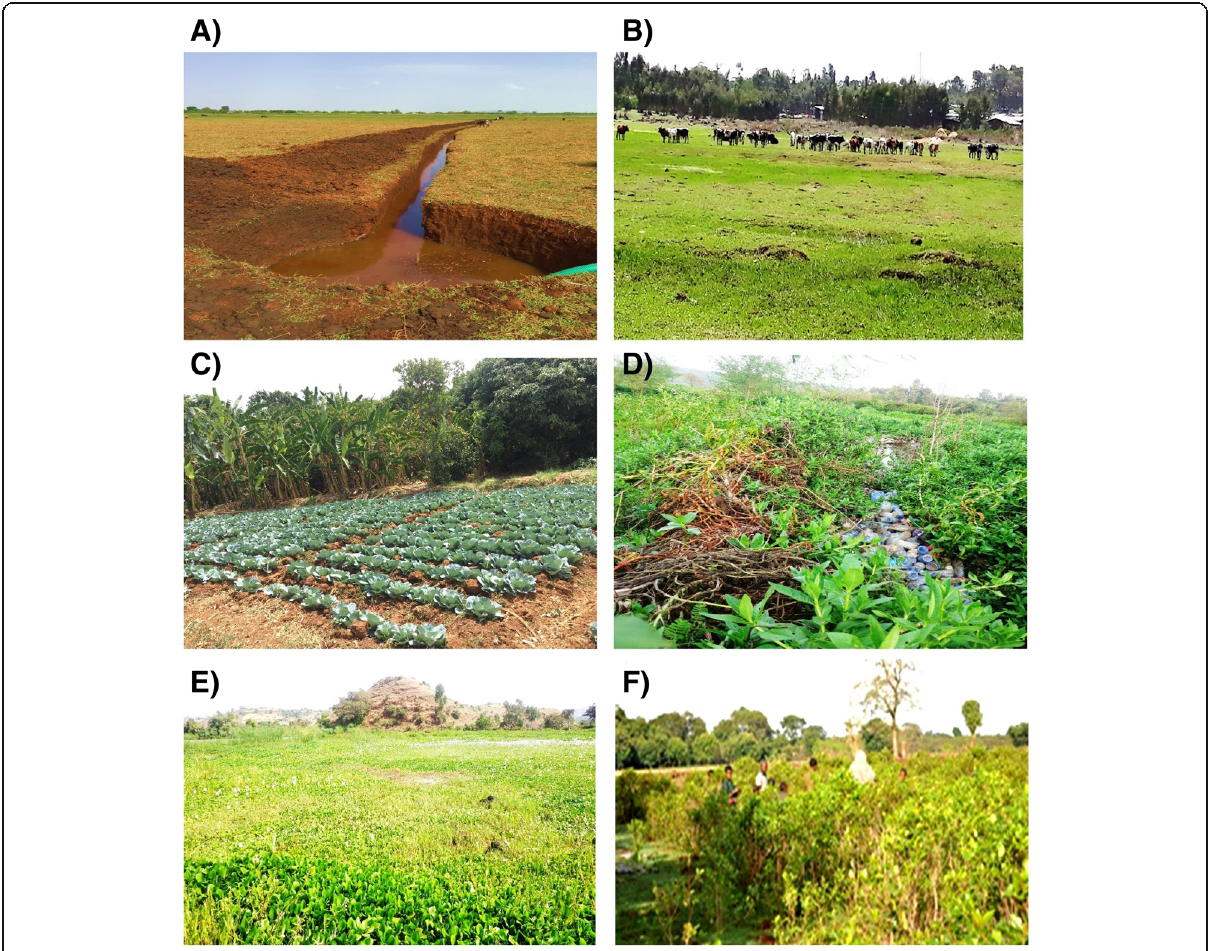
Fig. 5 Photographs showing anthropogenic activities affecting wetland ecosystem in urban and peri-urban areas of Bahir Dar City. a Water withdrawal from the wetland for irrigation. b Eucalyptus plantation and illegal settlement. c vegetables cultivation. d pollutants discharging into the wetland. e an invasion of water hyacinth on the Blue Nile riverbank, including nearby wetlands. f Khat cultivation